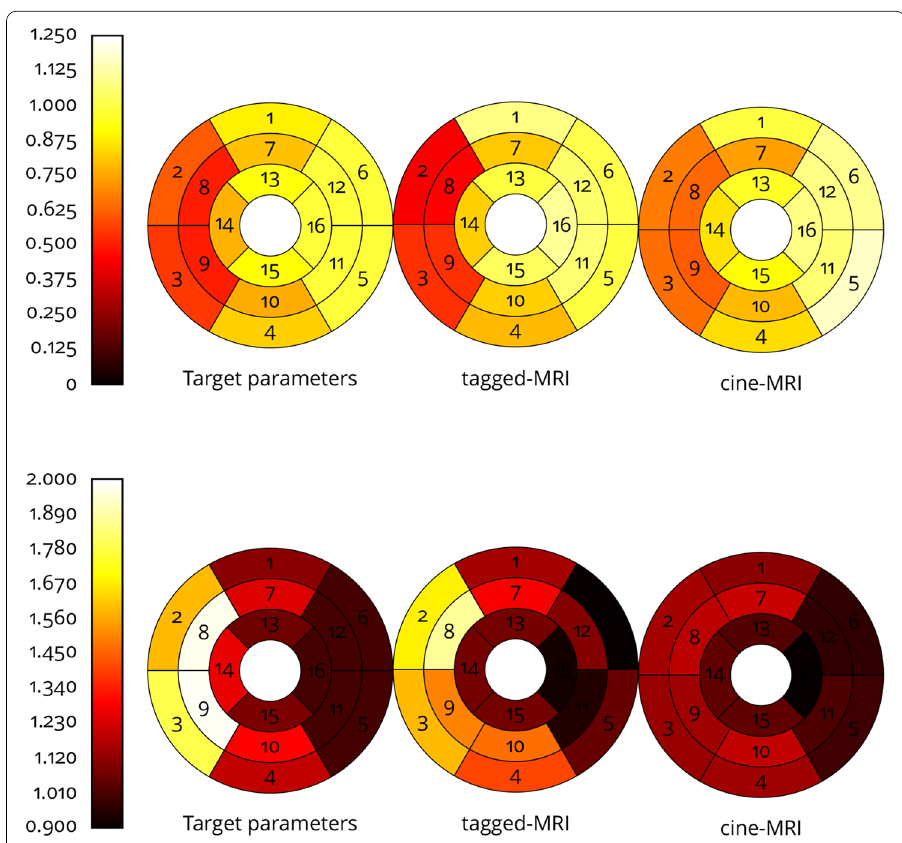
Fig. 19 Estimation of active (top row) and passive (bottom row) parameters using tag planes (middle column) and cine surfaces (right column) with coarse time sampling of the observations